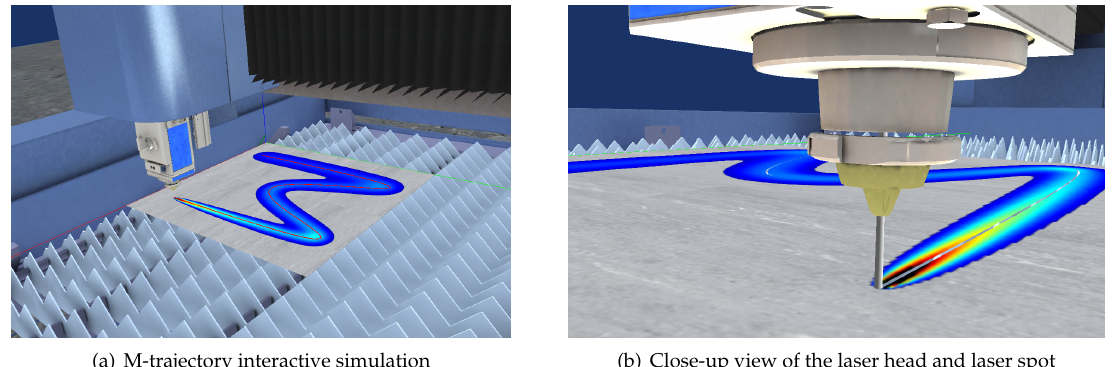
Figure 14. Interactive laser heating/cutting simulator. A virtual CNC machine follows the laser trajectory defined by the program and the physical module computes the temperature using the